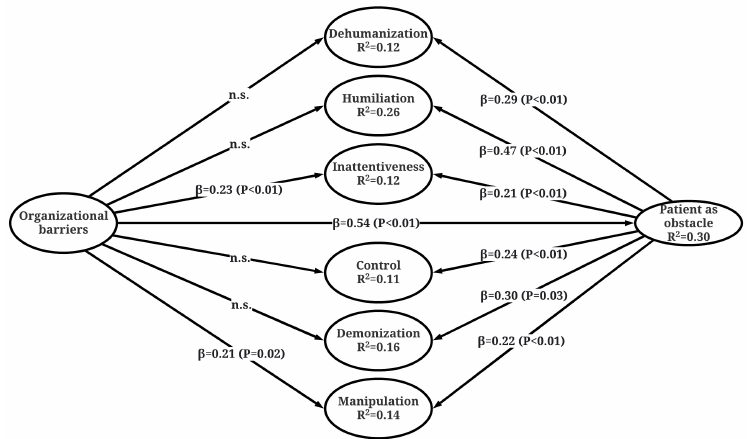
Figure 1. Path analysis of associations between the facets of Barriers to Dignity Assurance and Dignity